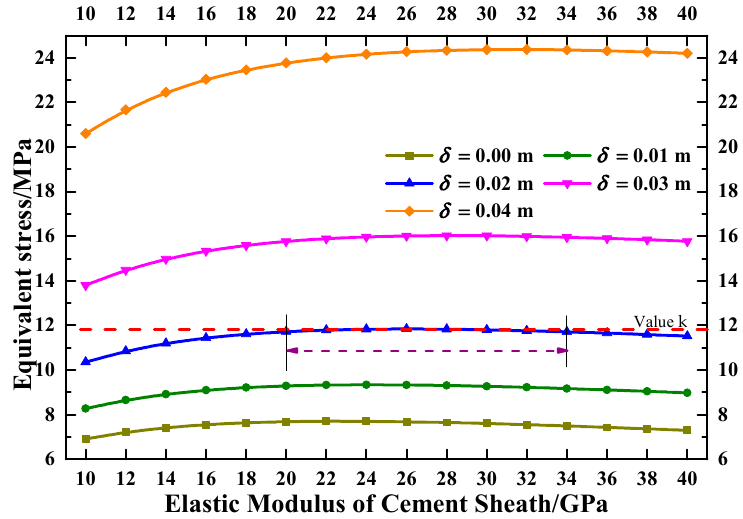
Figure 15. Variation of equivalent stress with the increase of cement elastic modulus.